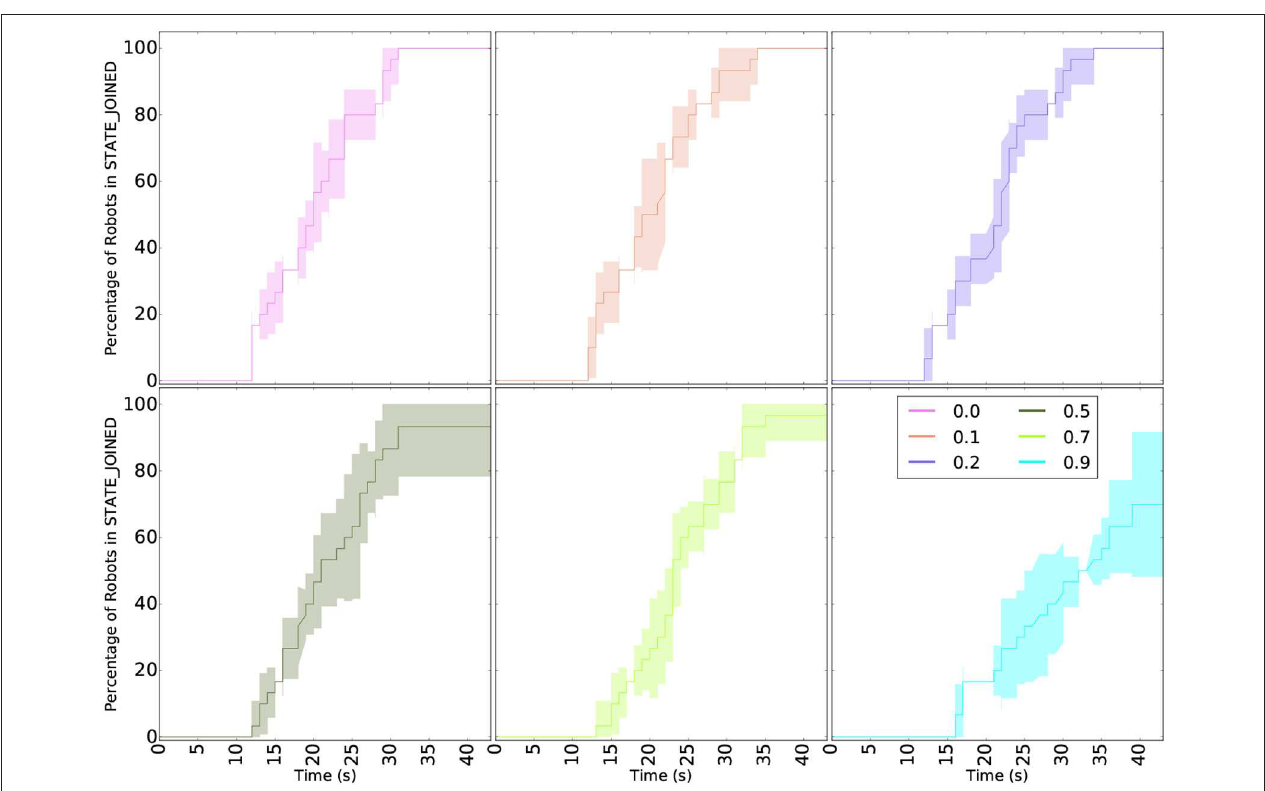
FIGURE 6 | Robustness to packet drop of the task allocation algorithm presented in section 3.1.1. The curves show the percentage of robots in the last state of the algorithm: JOINED. Each scenario (packet drop rate) was ran 5 times and the variability of the results are shown in the area around the curves. All simulations were ran with 6 robots. The algorithm converges in most runs up to 70% packet